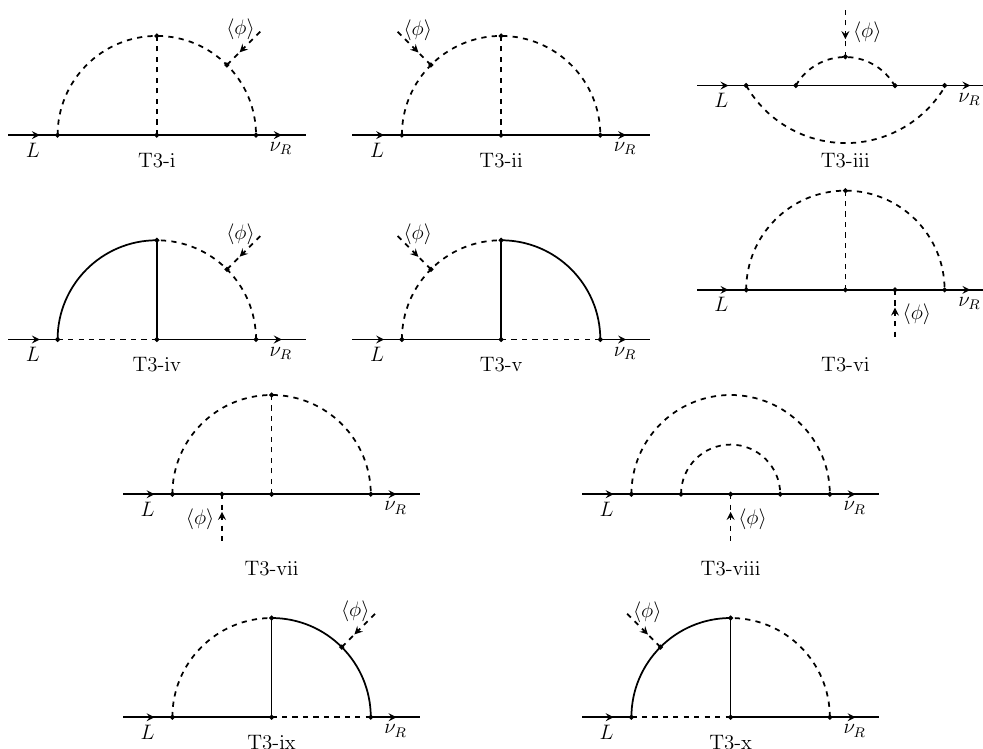
Figure 4 . Set of (cid:12)nite diagrams with a compressible fermion-fermion-scalar vertex. These two- loop diagrams can be the dominant contribution to neutrino masses, provided the lower order contributions are forbidden by a softly broken symmetry. Note that each diagram contains a soft vertex which breaks the symmetry forbidding the lower order